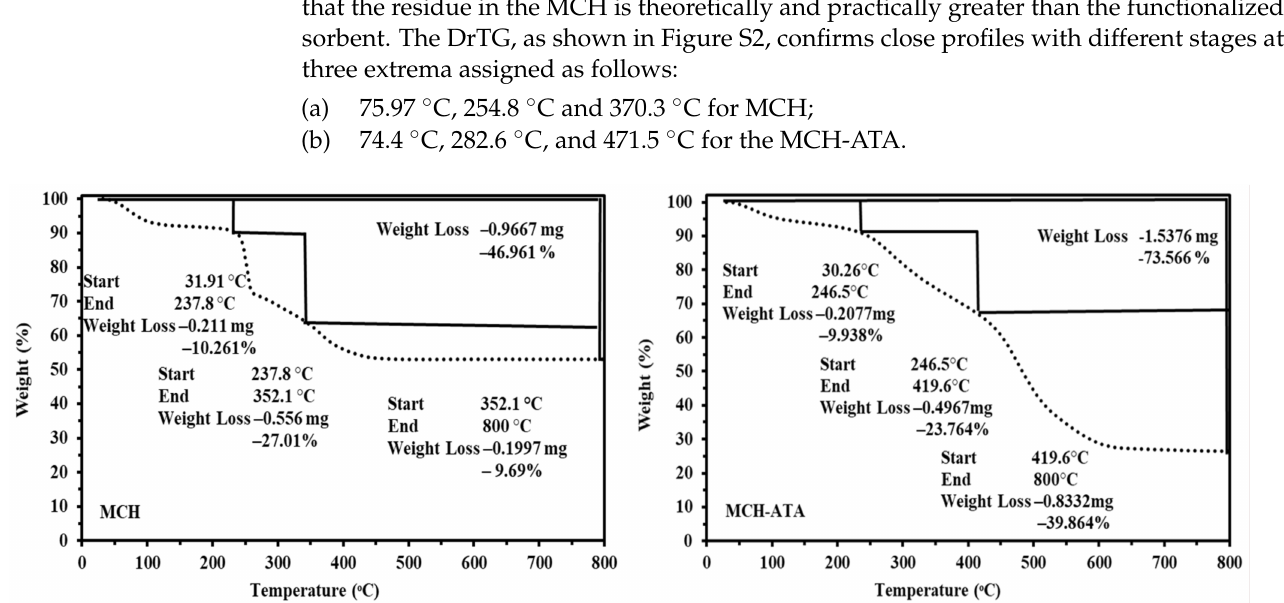
Figure 2. TGA analysis of MCH and MCH-ATA